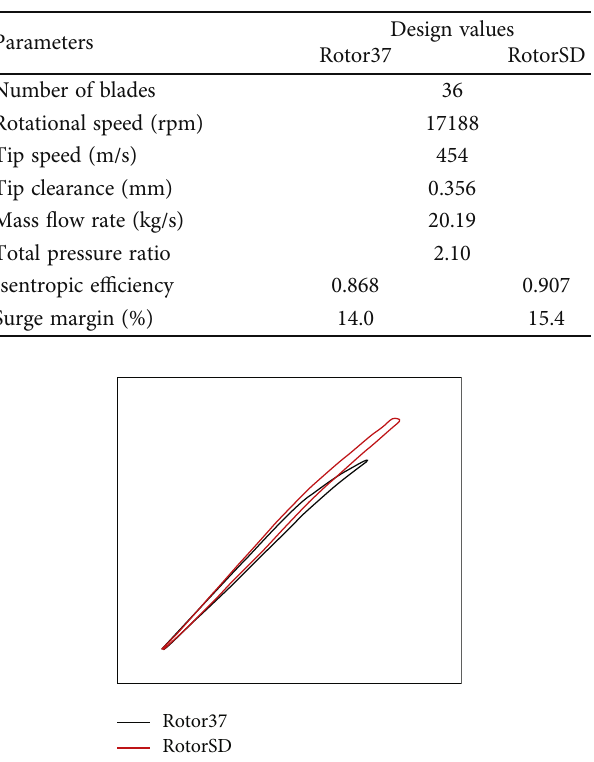
Table 1: Main parameters of the two rotors.